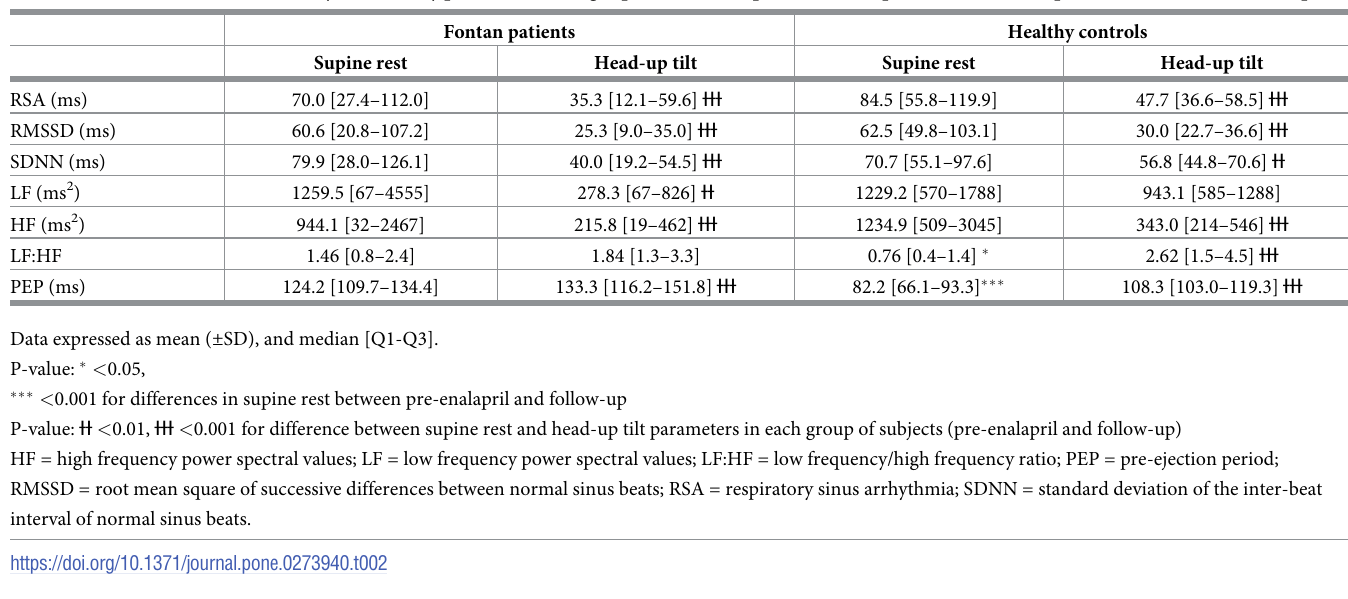
Table 2. Cardiac autonomic nervous system activity parameters during supine and head up tilt in Fontan patients before enalapril treatment and at